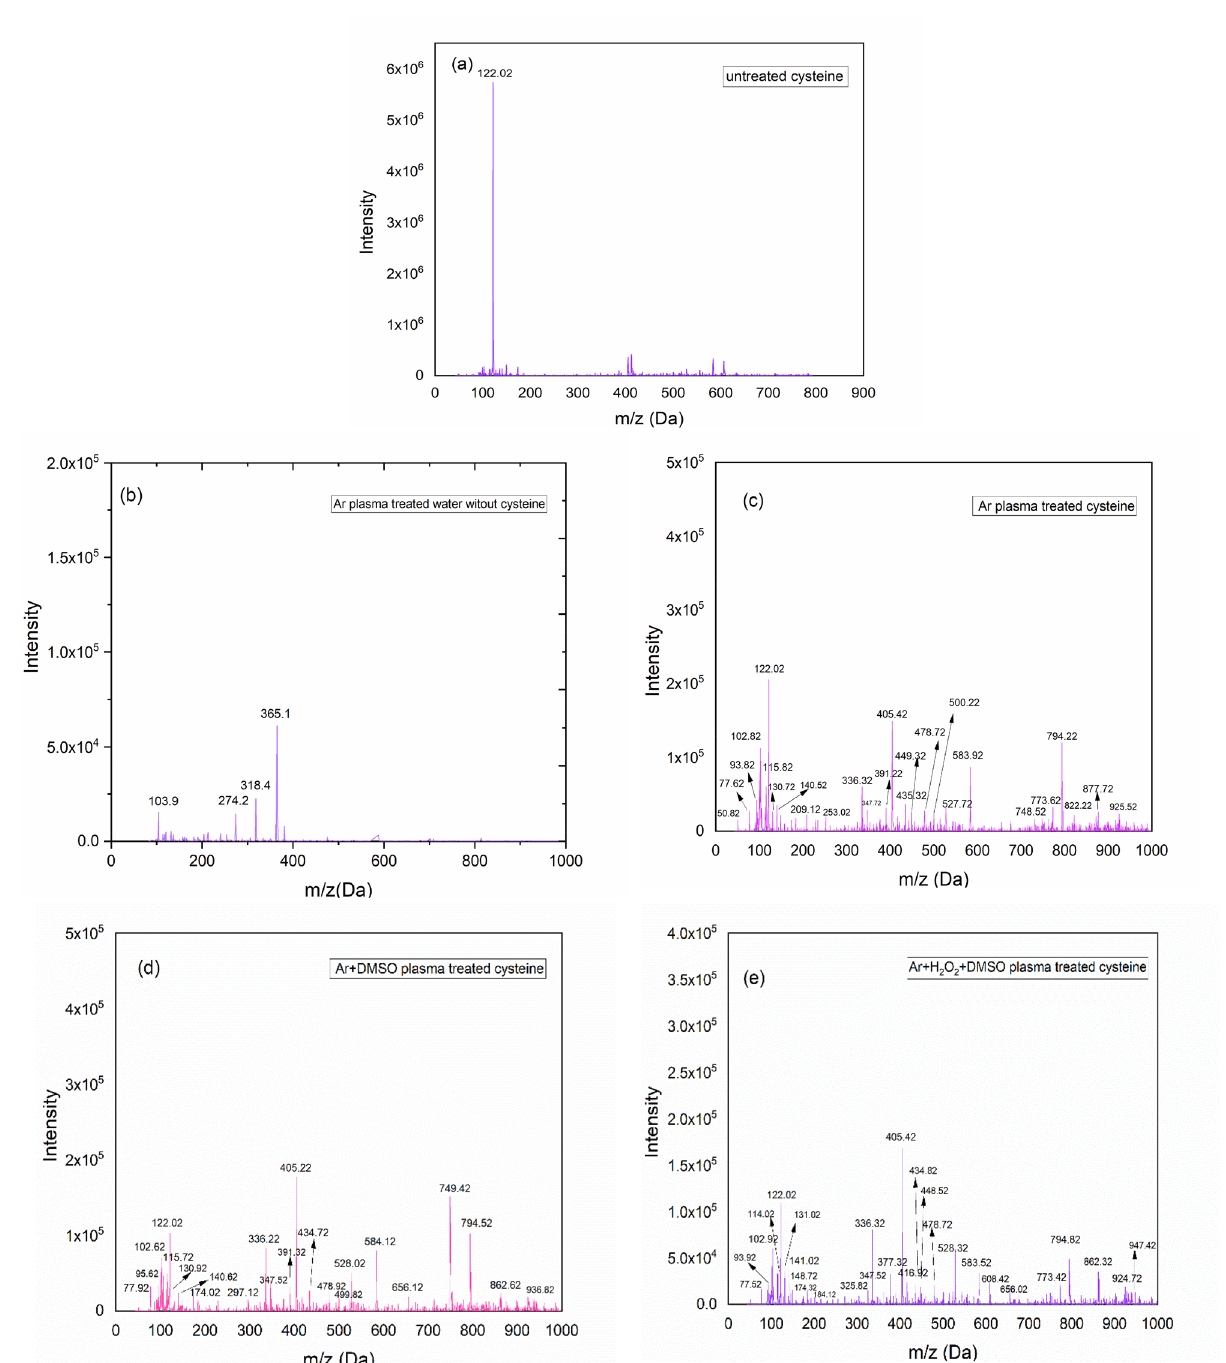
Figure 4. Mass Spectra of ( a ) untreated cysteine, ( b ) Ar plasma treated water without cysteine, and TSP- derived biomolecules from treated cysteine with ( c ) Ar plasma, ( d ) Ar + DMSO plasma, ( e ) Ar + H 2 O 2 +